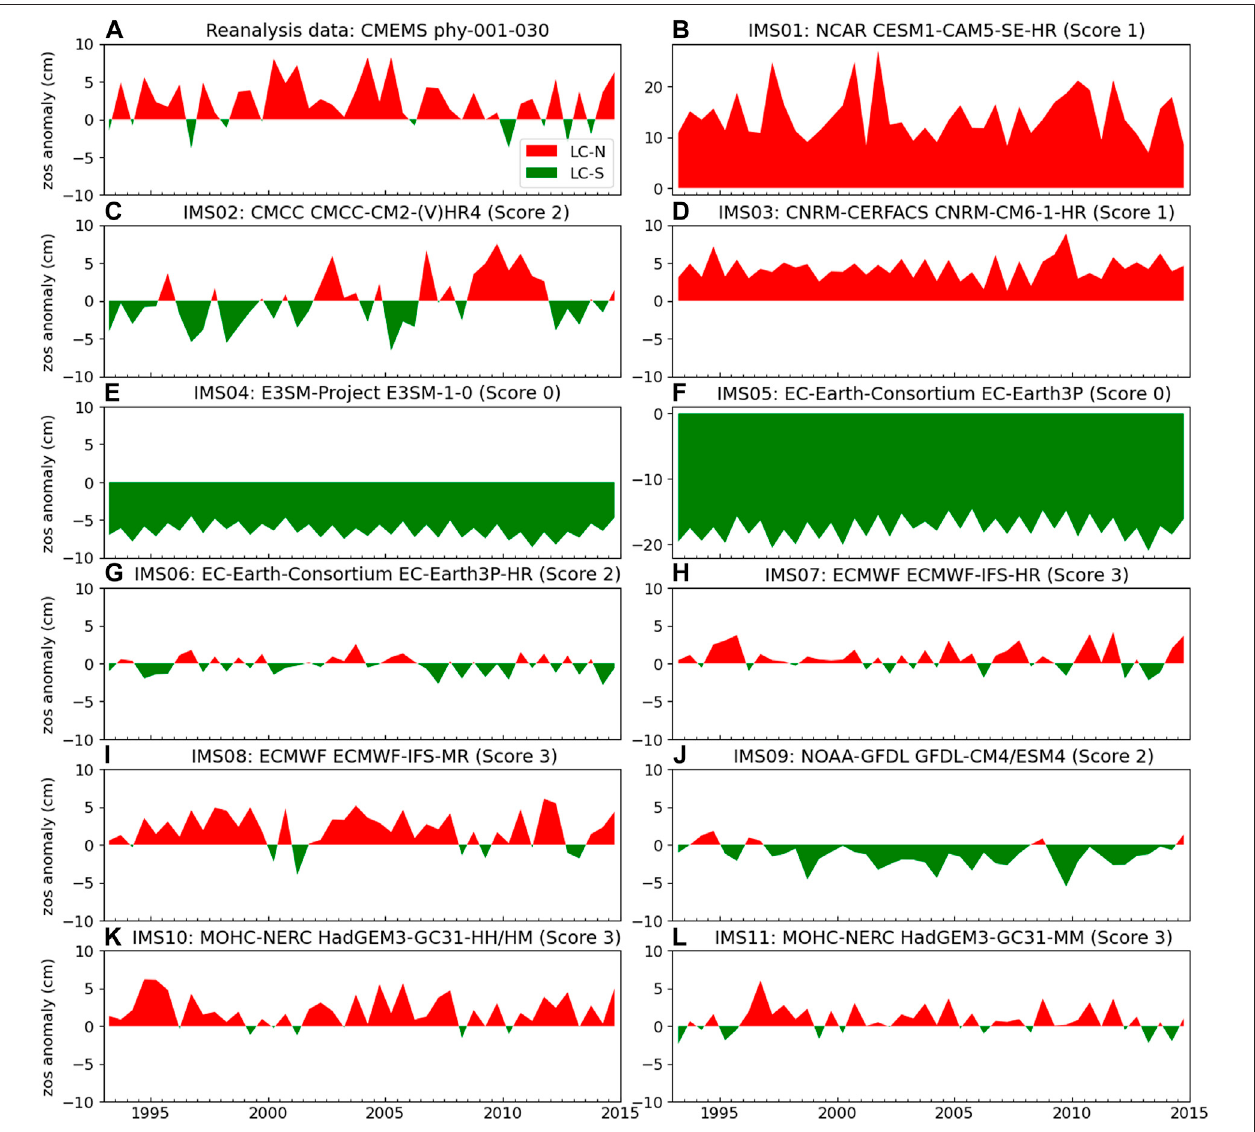
FIGURE5| Thesurfaceheightabovegeoid(zos)anomaly( Eq.5 )of (A) reanalysisdata,and (B – L) enesmblemembers(i.e,independentmodelsubsets).Thetitleof the reanalysis data shows the data provider name, and product ID. The title of ensemble member shows ensemble member number, modeling group name, model name(s), and ensmble member